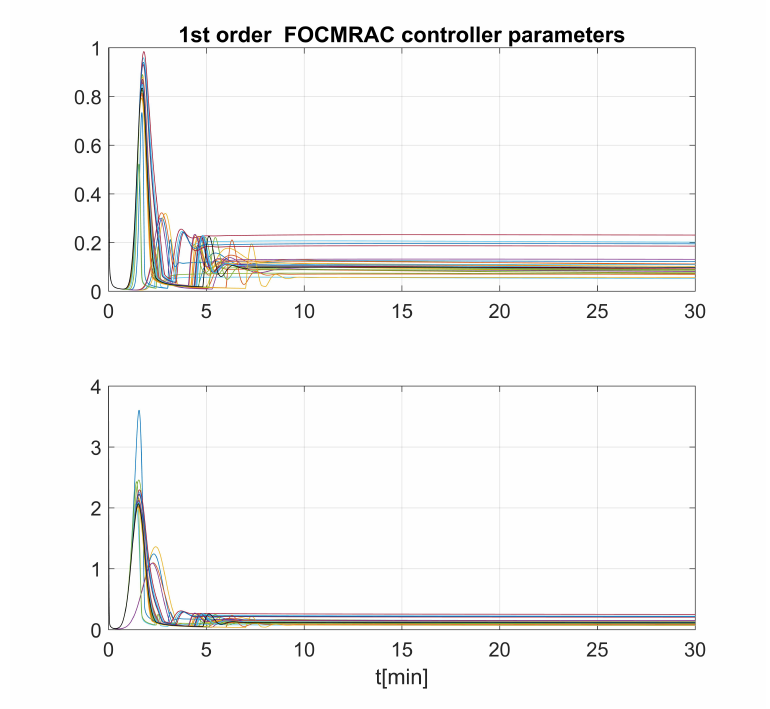
Figure 13. Controller parameters of the FCOMRAC scheme using the 1st-order